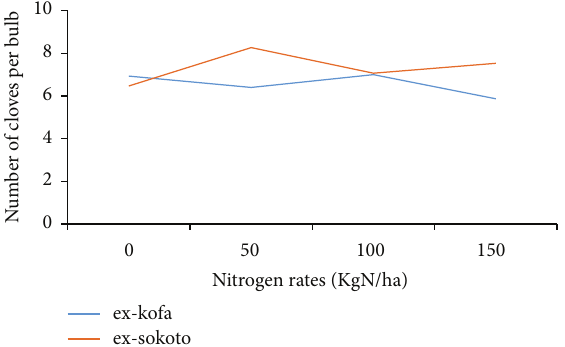
Figure 9: Interaction effect of variety and nitrogen rates on the number of cloves per bulb (LSD = 1.68